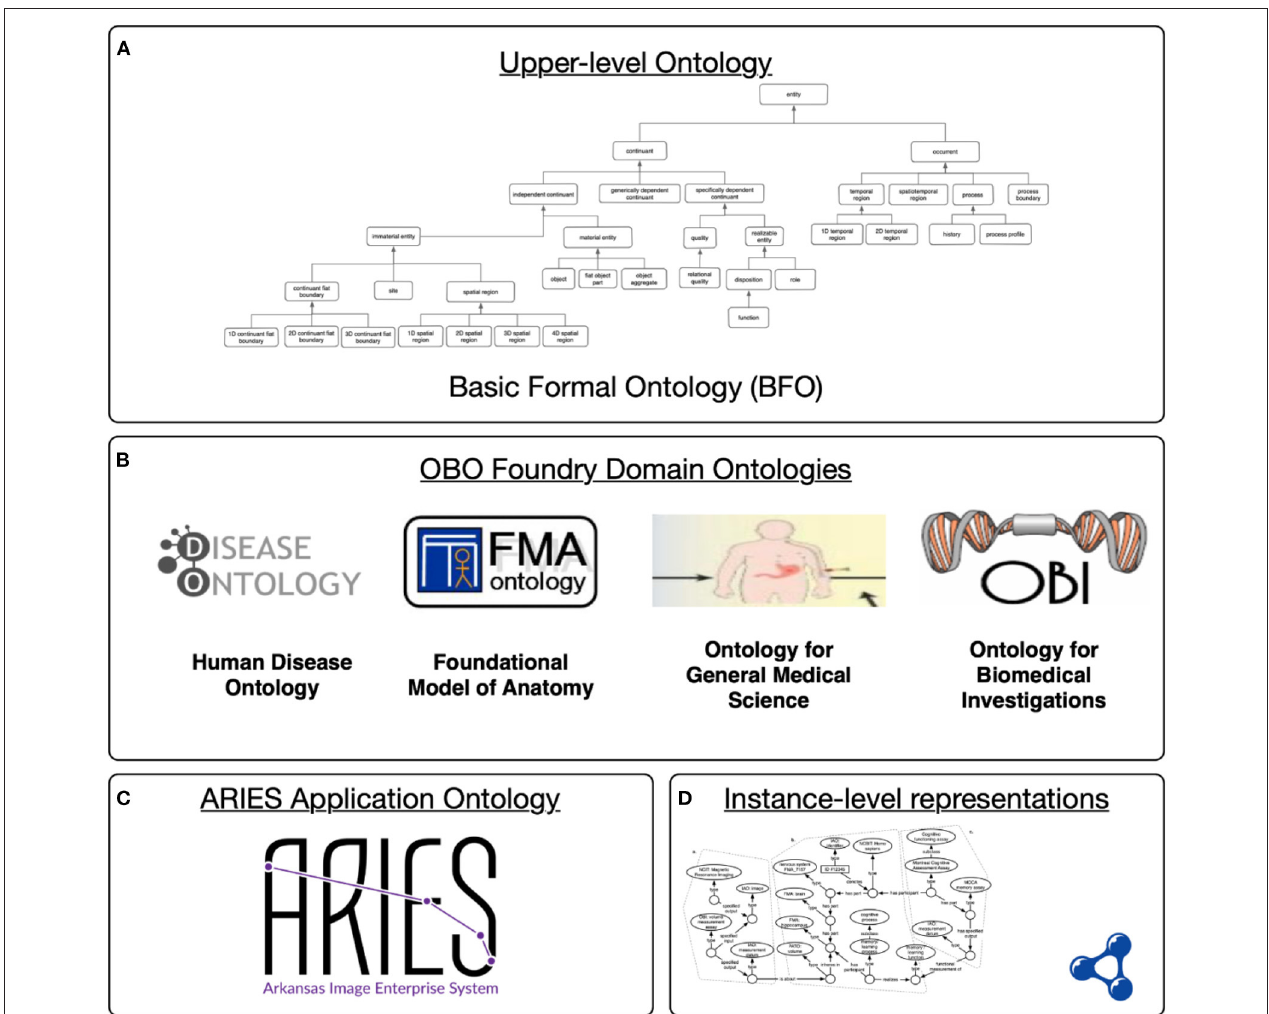
FIGURE 2 | Levels in the ARIES semantic infrastructure: (A) The upper level ontology provides a common language; (B) domains ontology extend this to cover a particular area of science; (C) ARIES application-specific terms and definitions for our project; (D) ARIES knowledge graph containing instance data aligned with the domain and application